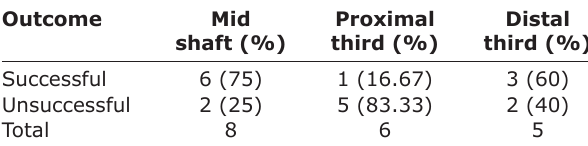
Table-1: Fracture site wise success rate of C-arm guided closed intramedullary pinning.